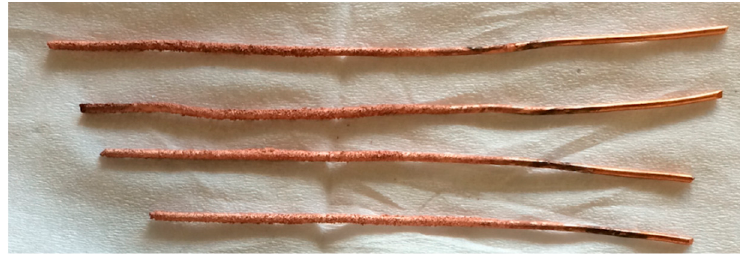
Figure 7. Examples of dried copper wire cathodes with a hard adherent Cu–SWCNT composite coating.